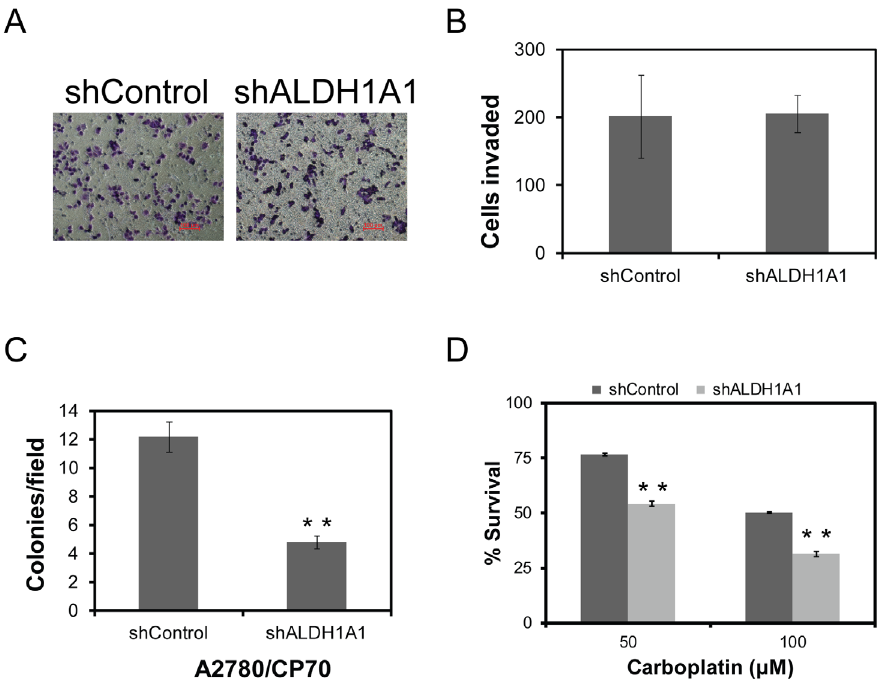
Figure 4. ALDH1A1 down regulation differentially affects on cancer stem cell properties. Lentiviral vectors expressing ALDH1A1 specific shRNAs or nontargeting shRNAs were transfected into A2780/CP70 cells and its effect on stem-like cell properties were evaluated for invasive potential using Matrigel invasion chambers (A), quantitative data as represented (B), clonogenic potential using soft agar colony formation (C, and carboplatin dependent growth inhibition by CellTiter-Glo Luminescent Cell Viability Assay (D). Statistical significance was evaluated using student’s t- test.